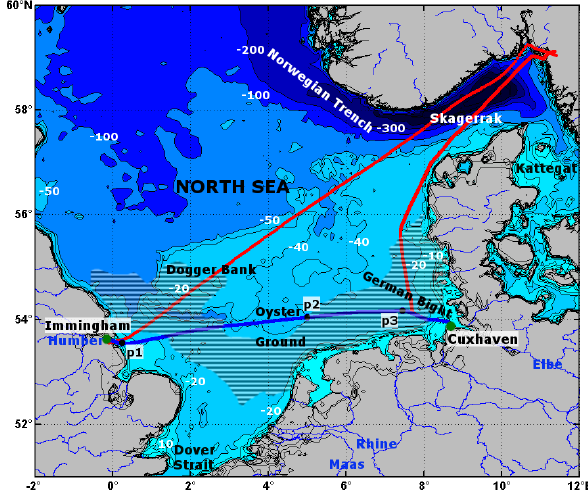
Figure 1. FerryBox routes and crossing points in the North Sea. The blue line marks TorDania route Cuxhaven–Immingham and the red lines indicate Lysbris route England–Norway–Germany. Spe- cific analysis points of FerryBox routes are indicated by black dots and labelled p1, p2, and p3. p1 is situated at the English eastern coast. p2 marks the analysis point in the Oyster Ground area. At p3, MARNET station Deutsche Bucht is located. The hatched area marks the transition zone between well-mixed and stratified surface layers (adapted from OSPAR, 2000, and Becker,